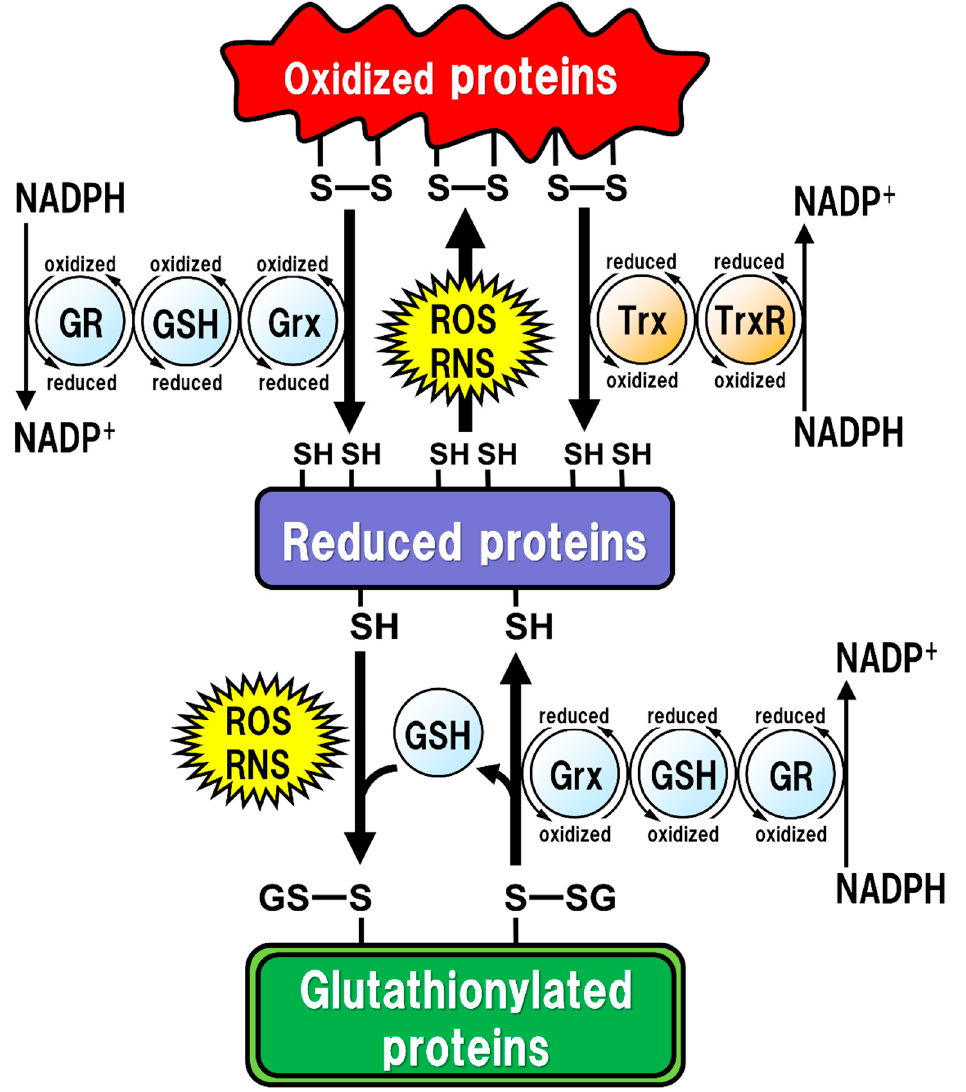
Figure 1. Regulation of the intracellular protein redox state by glutathione (GSH), glutaredoxin (Grx), and thioredoxin (Trx). Reactive oxygen species (ROS) and reactive nitrogen species (RNS) cause protein dysfunction, which is induced by the oxidation of thiol (SH) residues to form disulfide (S-S) bonds in the active site. Grx and Trx regulate protein function by reducing the S-S bonds of the substrate proteins. Consequently, Grx and Trx themselves result in the oxidized forms, which are reduced back by GSH and Trx reductase (TrxR), respectively. Oxidized GSH (GSSG) is reduced back to GSH by GSH reductase (GR). Both oxidized TrxR and GR are reduced by receiving electrons from nicotinamide adenine dinucleotide phosphate (NADPH). Under oxidative stress conditions, GSH can bind to cysteine residues (GS-S) in a process known as ‘ S -glutathionylation’ to prevent the irreversible dysfunction of the proteins. Grx also functions in the deglutathionylation of the GS-S containing proteins to resume protein functions under physiological conditions.